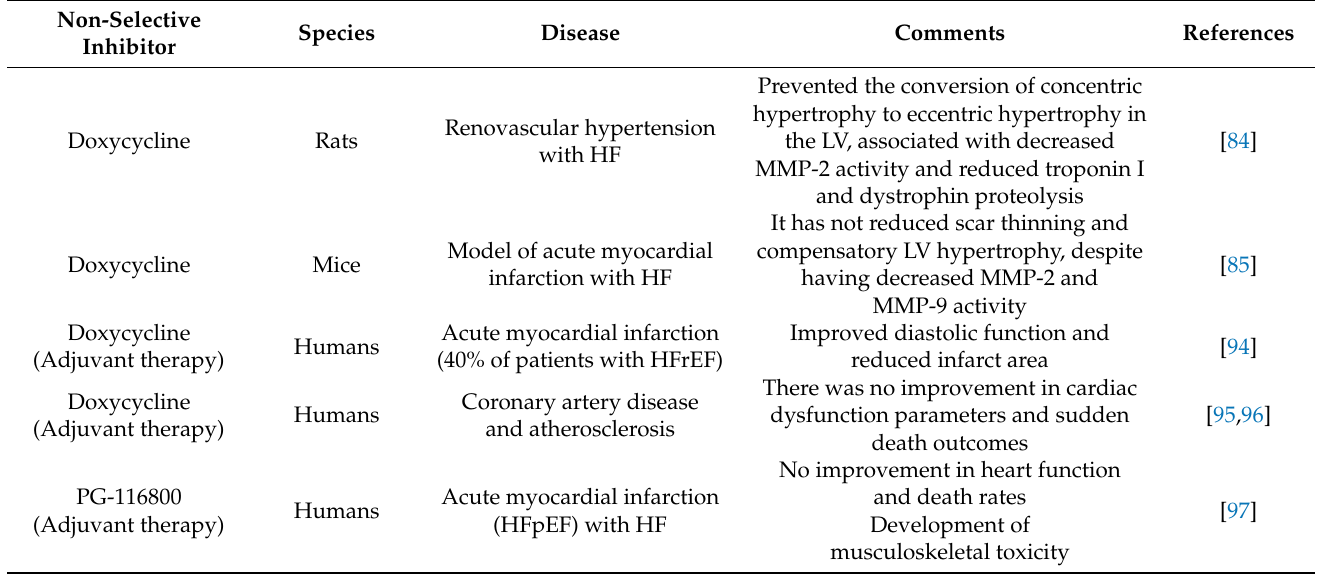
Table 4. Non-selective and selective MMP-2 inhibitors were evaluated in preclinical and clinical studies of